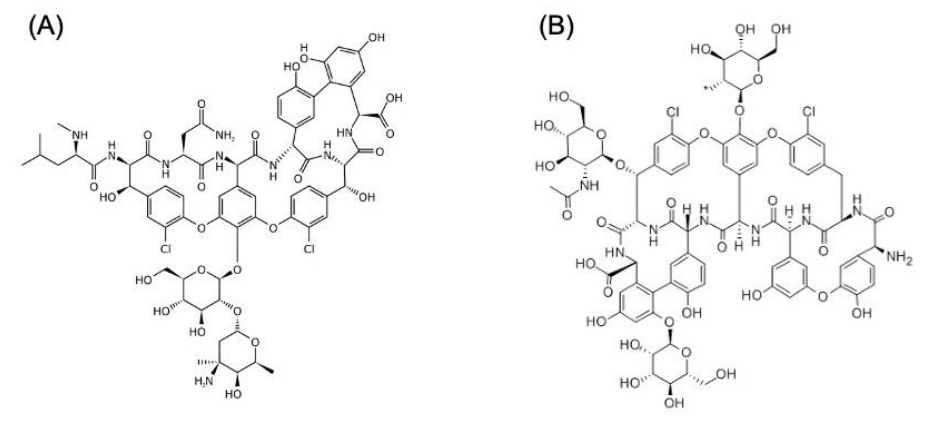
Figure 5. A differential pulse voltammogram at the MIP electrode using FMMA with the VCM con- centration of 0 (black), 10 (red), 20 (blue), 30 (green) and 40 (purple) μM. (The peak current de- creased with the number of measurements, independent of the VCM concentration).